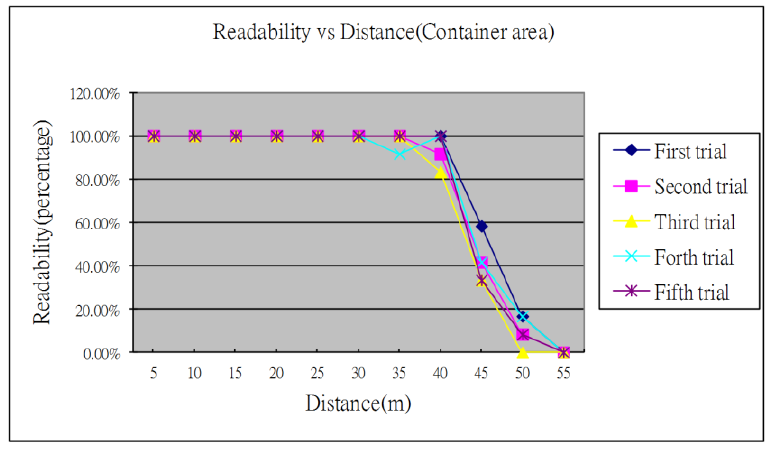
Figure 12. Relationship between readability and distance in container